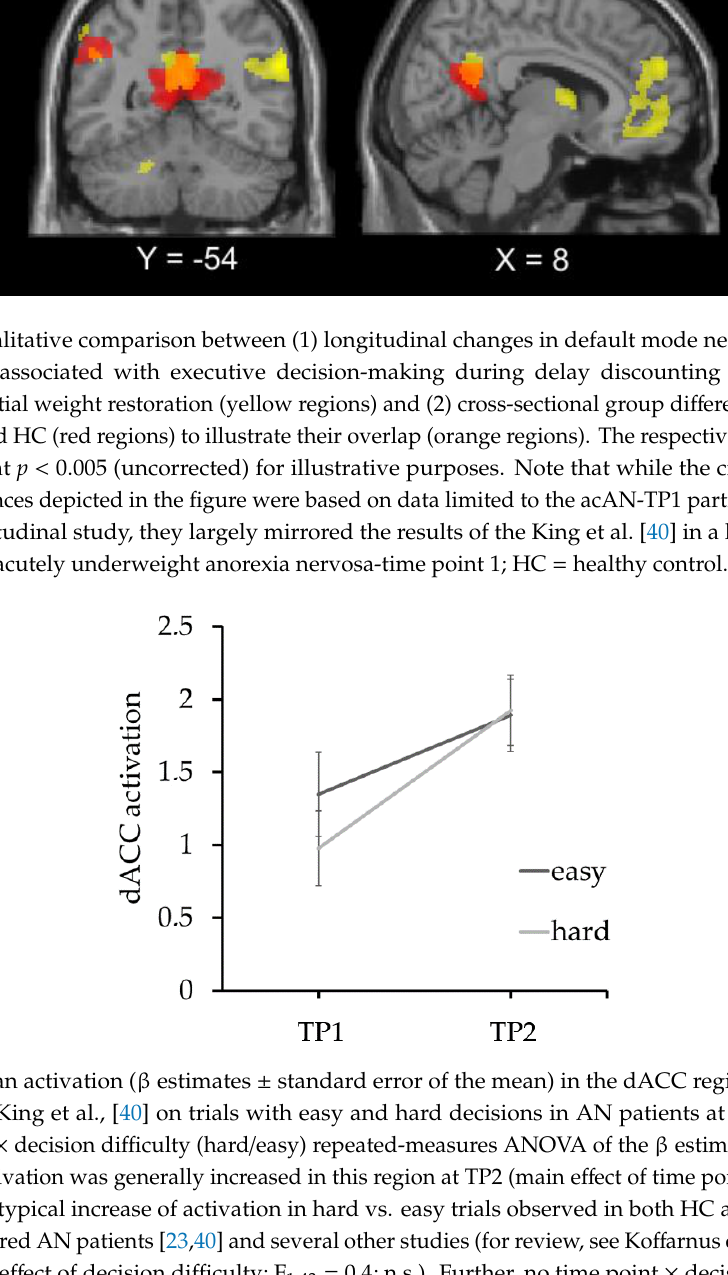
Figure 4. Qualitative comparison between (1) longitudinal changes in default mode network (DMN) deactivation associated with executive decision-making during delay discounting (regressor 1), following partial weight restoration (yellow regions) and (2) cross-sectional group differences between acAN-TP1 and HC (red regions) to illustrate their overlap (orange regions). The respective t-maps were thresholded at p < 0.005 (uncorrected) for illustrative purposes. Note that while the cross- sectional group differences depicted in the figure were based on data limited to the acAN-TP1 participants in the current longitudinal study, they largely mirrored the results of the King et al. [40] in a larger sample. acAN-TP1 = acutely underweight anorexia nervosa-time point 1; HC = healthy control.